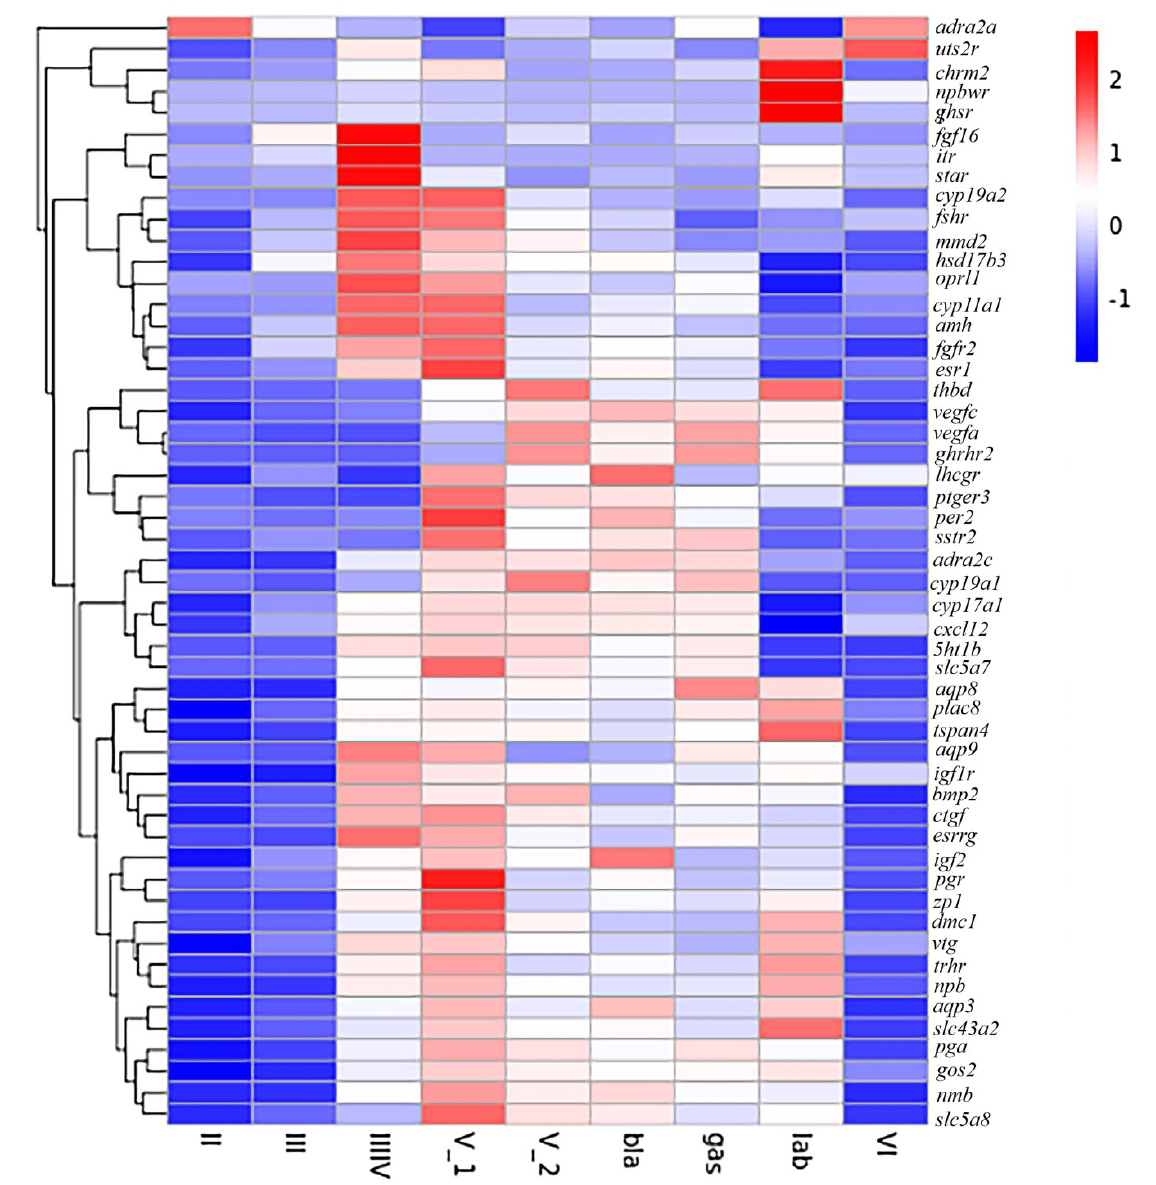
Figure 4. The heatmap of reproduction related DEGs expression pattern at different reproductive phases. The red and blue colors indicated up- and down-regulated transcripts, respectively.